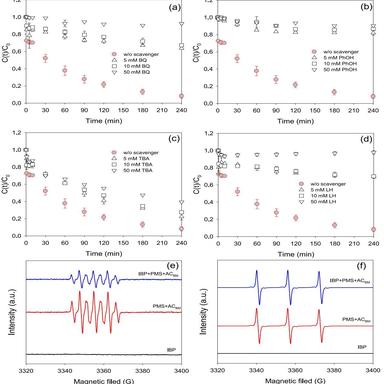
Chemical scavenger experiments in the ACBM/PMS system: (a) benzoquinone; (b) PhOH; (c) TBA; and LH. ESR analysis in the ACBM/PMS system with (e) DMPO and (f) TEMP for radical and non-radical ROS. Experimental conditions: = 0.1 mmol L− 1 , = 5 mM, = 0.1 g L–1 , = = 100 mM in 10 mM phosphate buffer at pH 7.